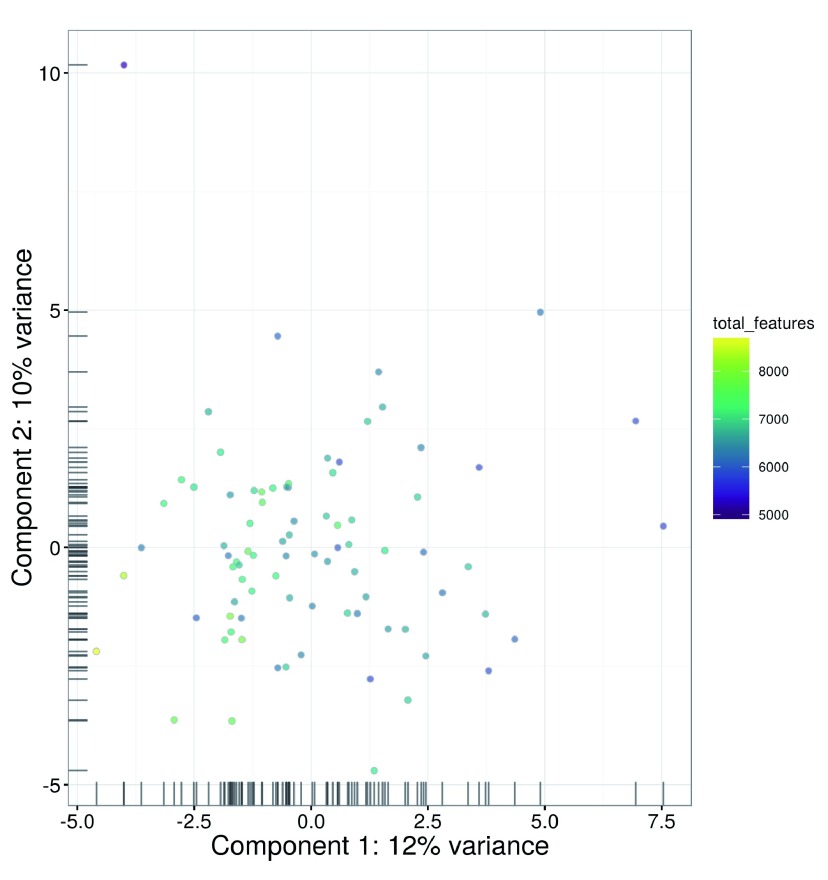
PCA plot constructed from normalized log-expression values of correlated HVGs, where each point represents a cell in the HSC dataset.First and second components are shown, along with the percentage of variance explained. Bars represent the coordinates of the cells on each axis. Each cell is coloured according to its total number of expressed features.